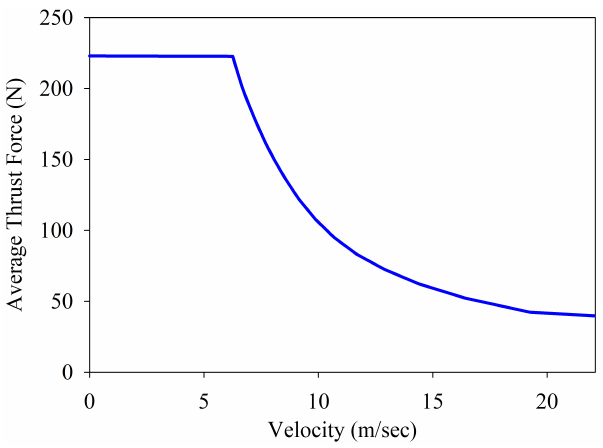
Figure 21. Average thrust force at different velocities.